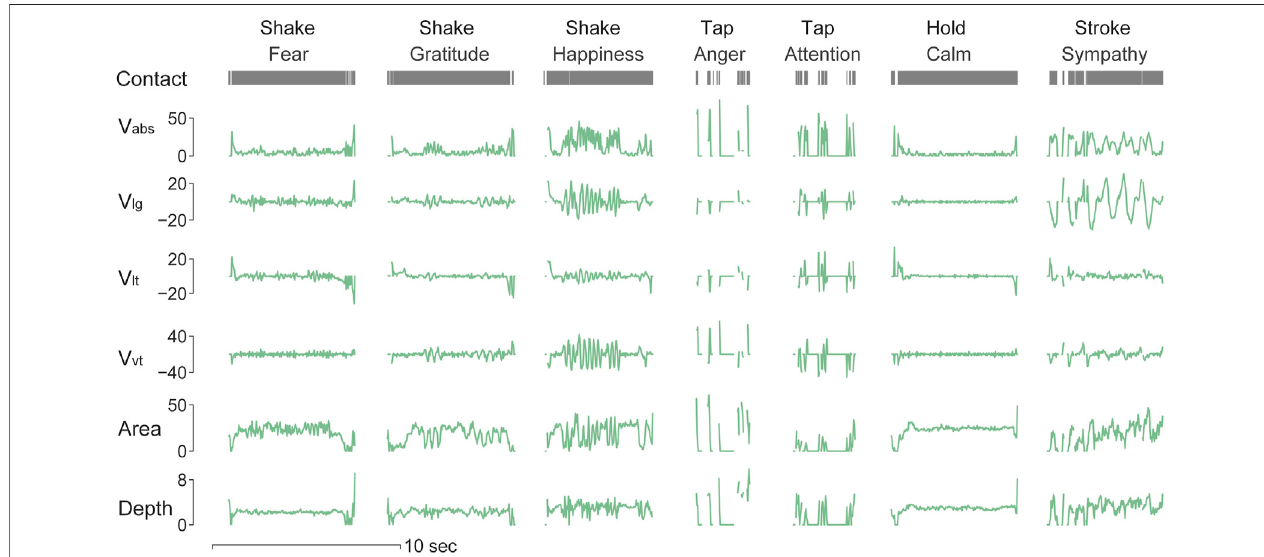
FIGURE 3 | Time-series recordings of each contact attribute across touch gestures and delivered messages. Distinct contact patterns were captured by the spatiotemporal changes of those attributes. The Contact variable represents the status of the being contacted or not. V abs denotes the absolute contact velocity (cm/s), V lg denotes the longitudinal velocity(cm/s), V lt denotes thelateral velocity (cm/s), V vt denotes the vertical velocity (cm/s), Area denotes the contact area (cm 2 ), and Depth denotes the indentation depth (mm).